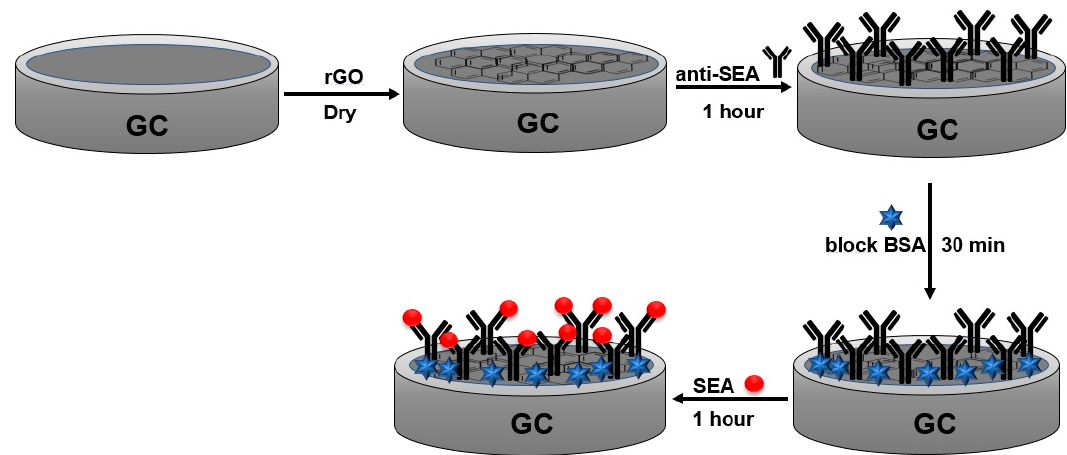
Figure 2. Schematic representation of the SEA immunosensor fabrication on a GC electrode.